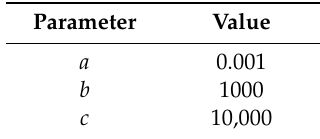
Table 2. Coe ffi cients in